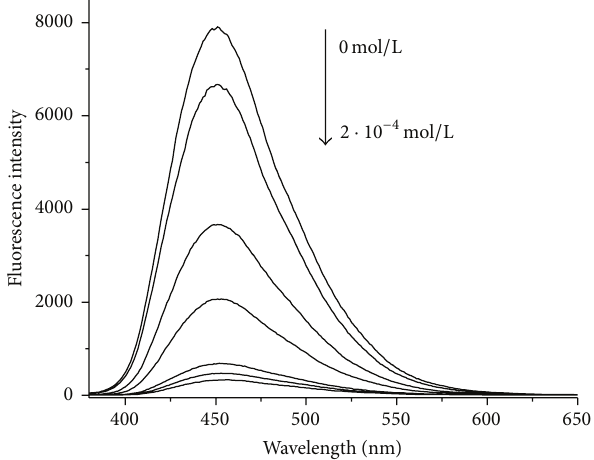
Figure 5: The influence of Fe 3+ cations on the fluorescence intensity of the poly(St-co-MD1) at different concentrations of Fe 3+ in aqueous